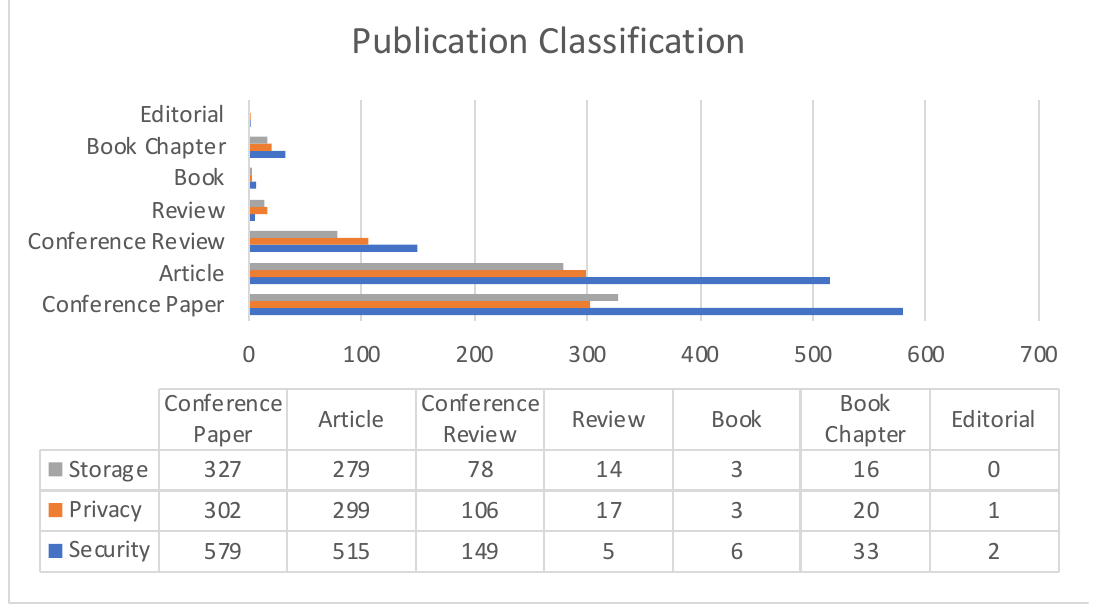
Figure 10. Publication classification comparison among Cloud impact areas.